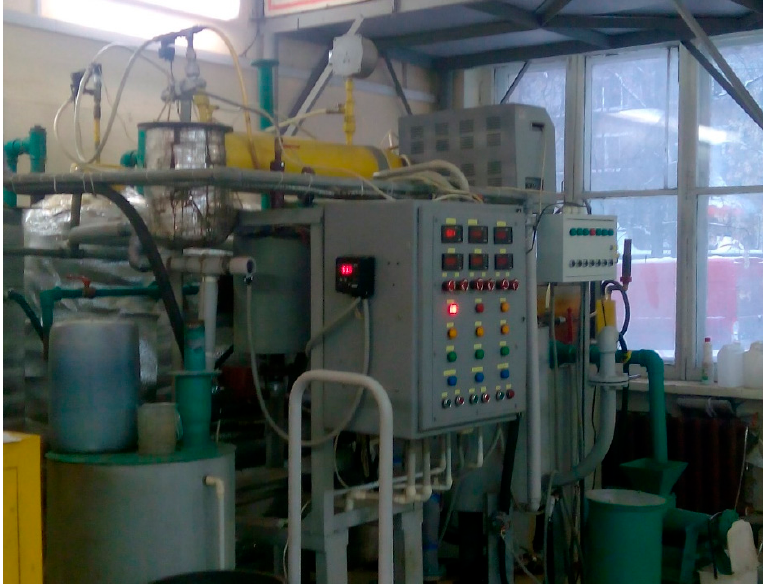
Figure 3. General view of the experimental semipilot AD plant.